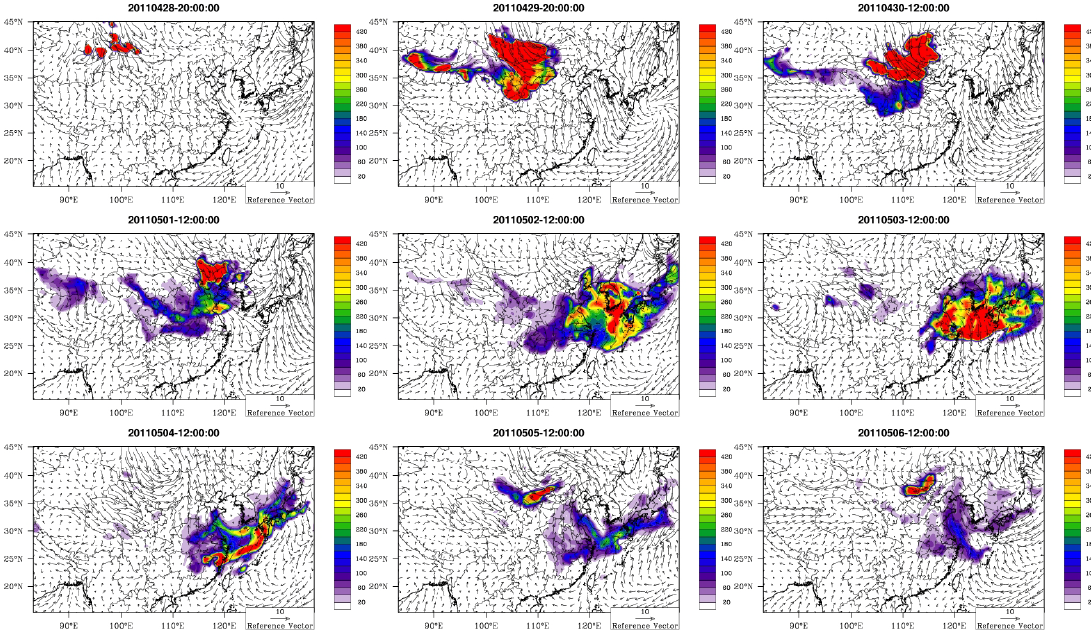
Fig. 8. The spatiotemporal variation of dust impacts on PM 10 concentration (µgm − 3 ) in the surface layer during this dust event Fig.8. The spatio-temporal variation of dust impacts on PM 10 concentration (μg/m 3 ) in the surface layer during this dust event (DUST_REVISED minus (DUST_REVISED minus DUST_OFF)